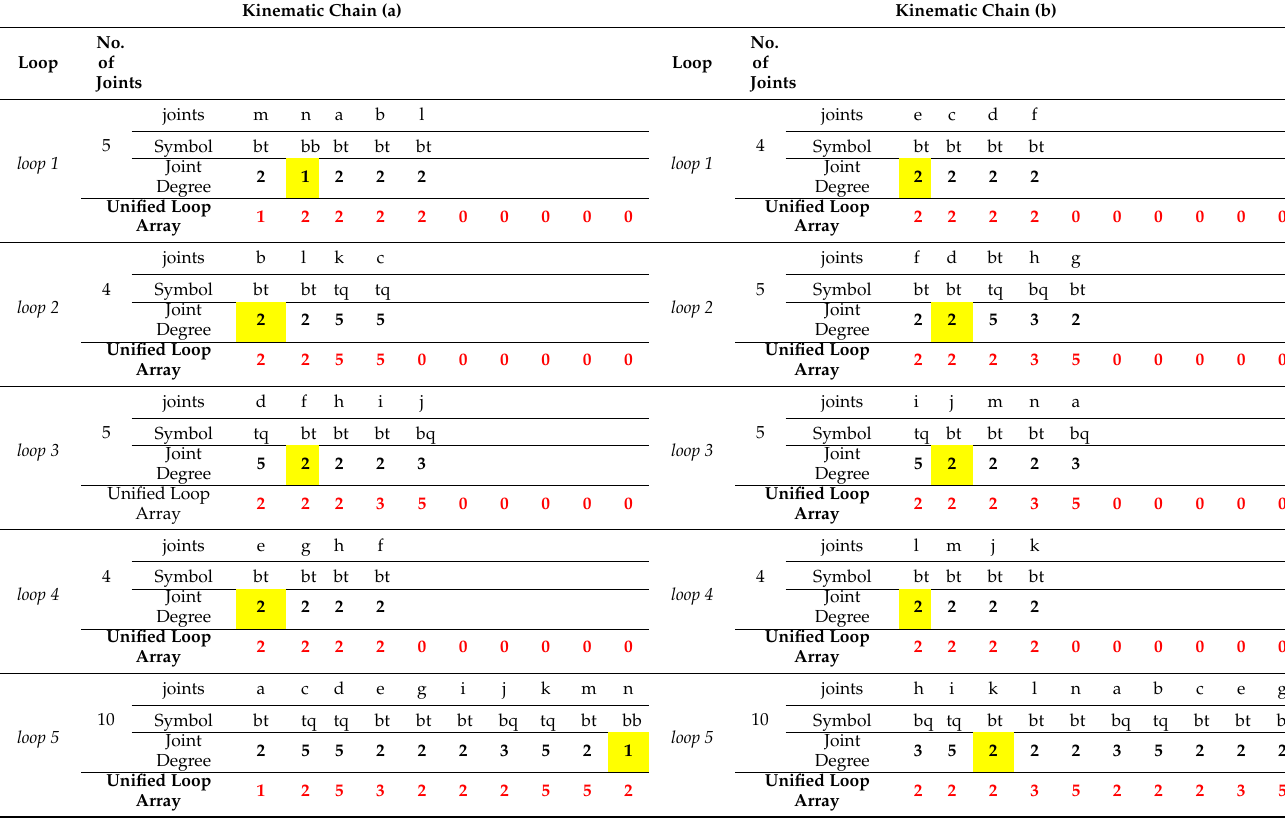
Table 4. Unified Loop Array for KC in Figure 9a,b.